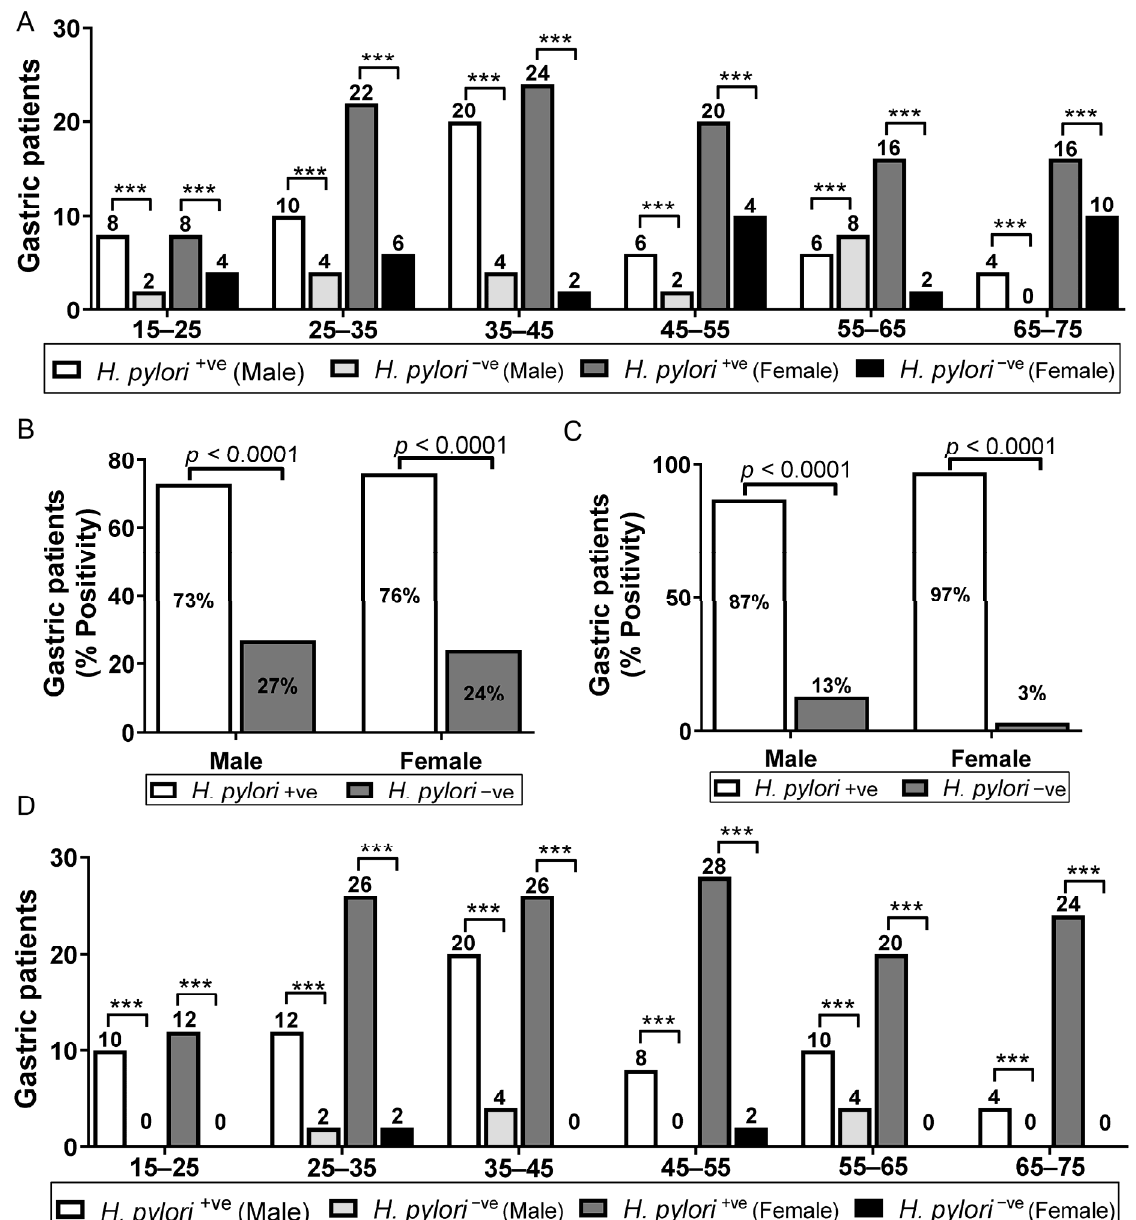
Figure 4. ( A ) Age-wise distribution of H. pylori infections in gastroduodenal ulcer and gastritis patients by IgM commercial ELISA kit (k M ELISA). ( B ) Sex-wise distribution of H. pylori infections in gastroduodenal ulcer and gastritis patients by IgM commercial ELISA kit (k M ELISA). ( C ) Sex-wise distribution of H. pylori infections in gastroduodenal ulcer patients and gastritis by IgG commercial ELISA kit (k G ELISA). ( D ) Age-wise distribution of H. pylori infections in gastroduodenal ulcer patients and gastritis by IgG commercial ELISA kit (k G ELISA). Three asterisks (***) indicate p value smaller than 0.001 ( p